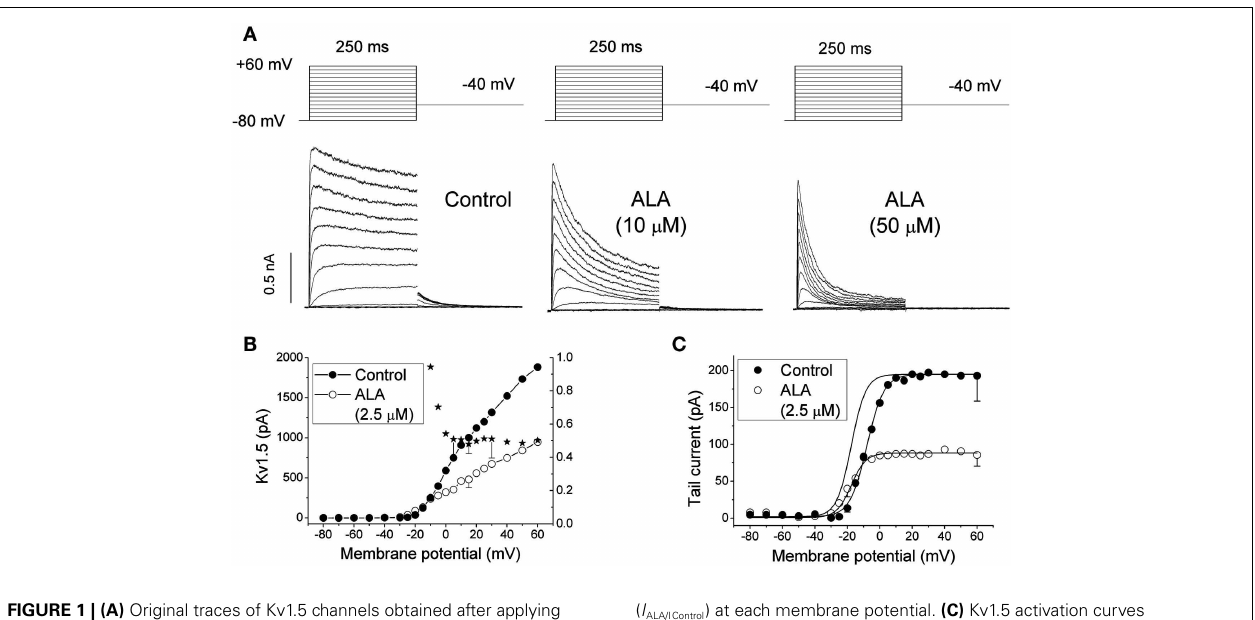
FIGURE 1 | (A) Original traces of Kv1.5 channels obtained after applying the pulse protocol shown in the upper part of the figure in the absence (Control) and in the presence of 10 and 50 µ M α -linolenic acid (ALA). (B) Current-voltage (IV) relationship of Kv1.5 in the absence and in the presence of 2.5 µ M ALA.The plot also shows the mean relative current